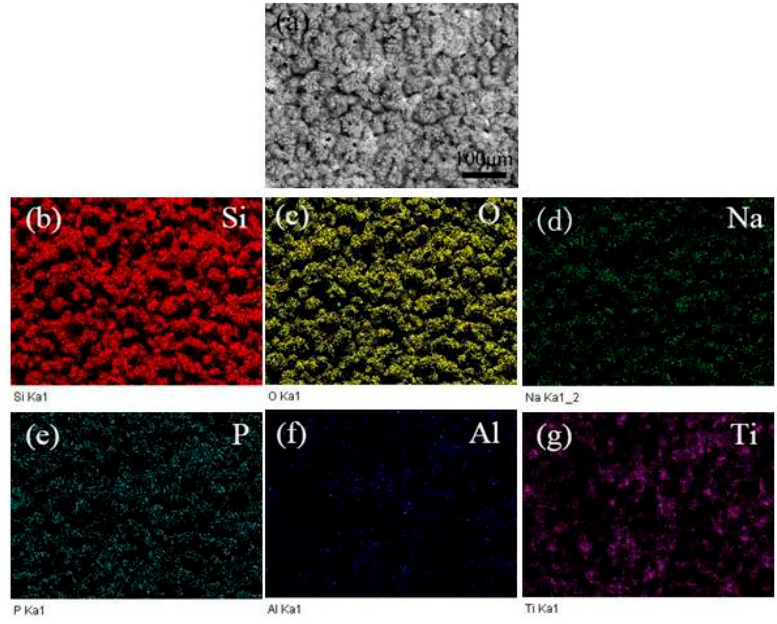
Figure 4. EDX mapping results of the sample prepared with 0 g/L concentration of KMnO 4 : ( a ) SEM morphology; ( b ) Si; ( c ) O; ( d ) Na; ( e ) P; ( f ) Al and ( g ) Ti.